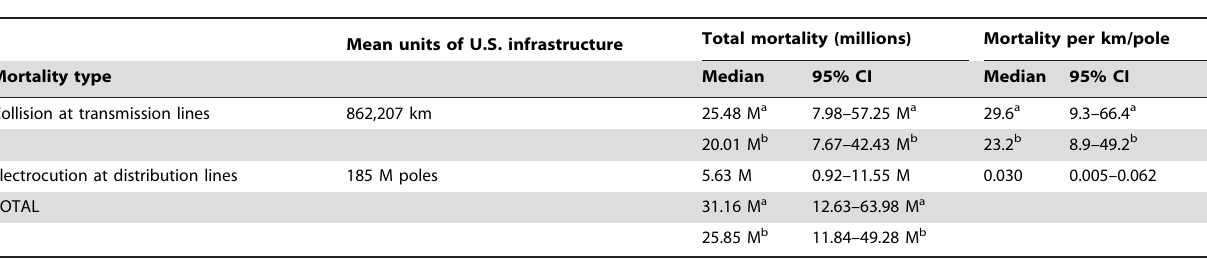
Table 3. Estimates of annual bird mortality at U.S. power